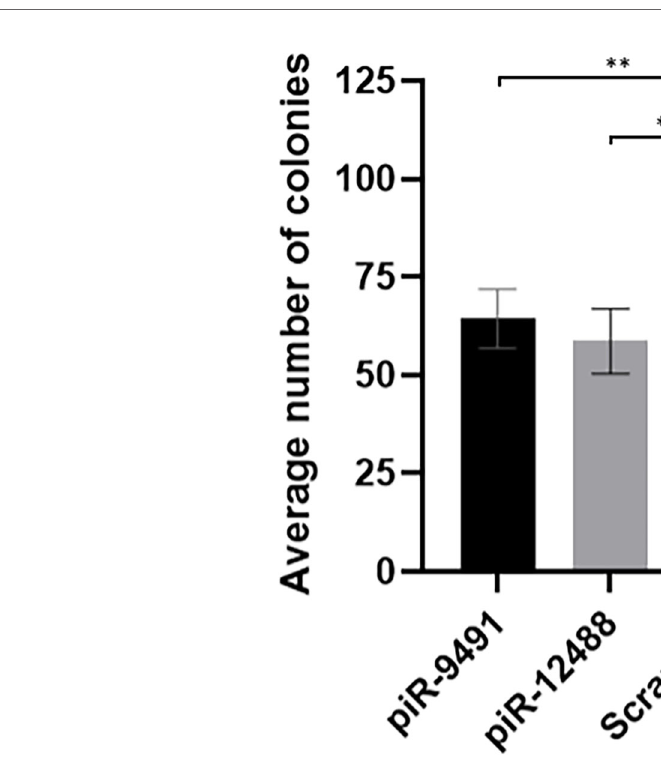
FIGURE 6 | Colony formation analysis results for hsa-piR-9491 and hsa-piR-12488 compared to scrambled oligonucleotide and MOCK negative control. Increased levels of piR-9491 and piR-12488 led to decreased number of colonies compared to scrambled oligonucleotide and U251 MG cells treated with transfection reagent without oligonucleotide (MOCK). ** p < 0.01, *** p <